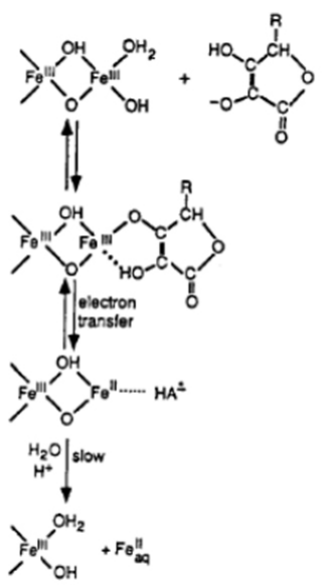
Figure 9: Reduction mechanism of iron(III) hydroxide to produce iron (II) ions [21].